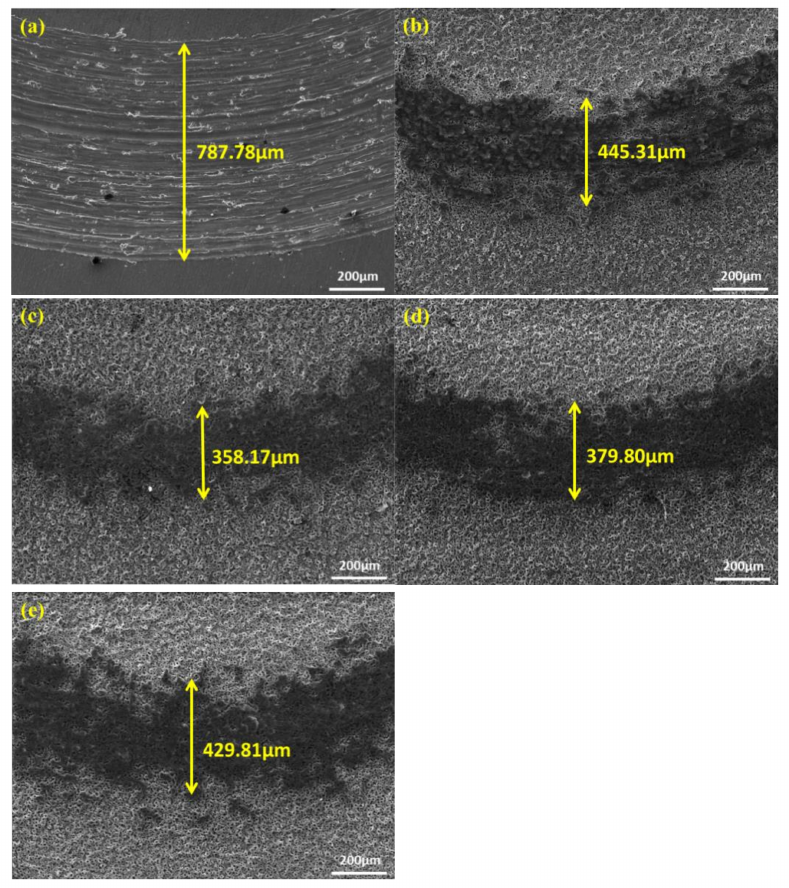
Figure 7. SEM image of the wear scar of both the TC4 alloy and the composite MAO coatings with different concentration of Si3N4/TaC particles: ( a ) TC4; ( b ) 0 g/L; ( c ) 1 g/L Si 3 N 4 + 0.5 g/L TaC; ( d ) 2 g/L Si 3 N 4 + 1 g/L TaC; ( e ) 4 g/L Si 3 N 4 + 2 g/L